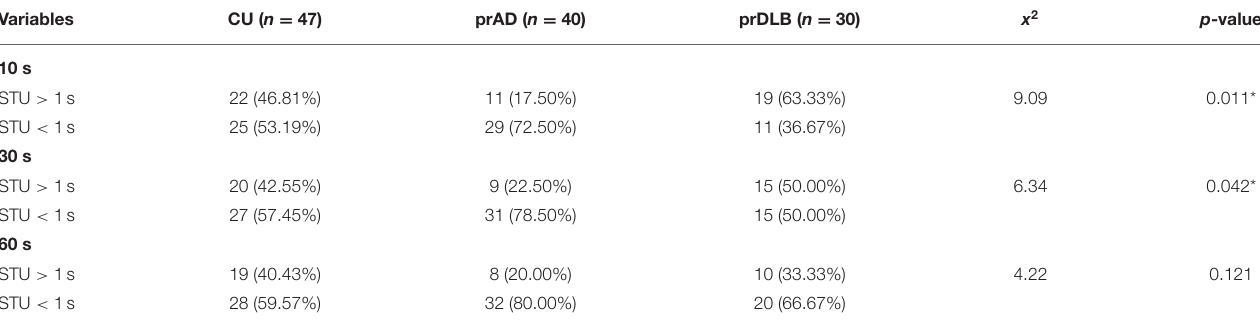
TABLE 6 | Time interval production test numbers of people STU lower or higher than